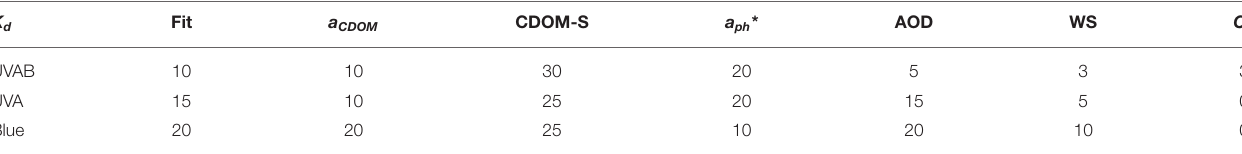
Model errors are defined for not correctly parameterizing in the VRS cross section and LUTs RTM simulations the specific oceanic [CDOM absorption slope (CDOM-S) and coefficient (a CDOM ), the phytoplankton absorption (a ph *)] and atmospheric parameters [aerosol optical thickness (AOD), wind speed (WS) and ozone concentration (O 3 )]. They are based on the sensitivity studies presented in section 3.3 and Dinter et al.